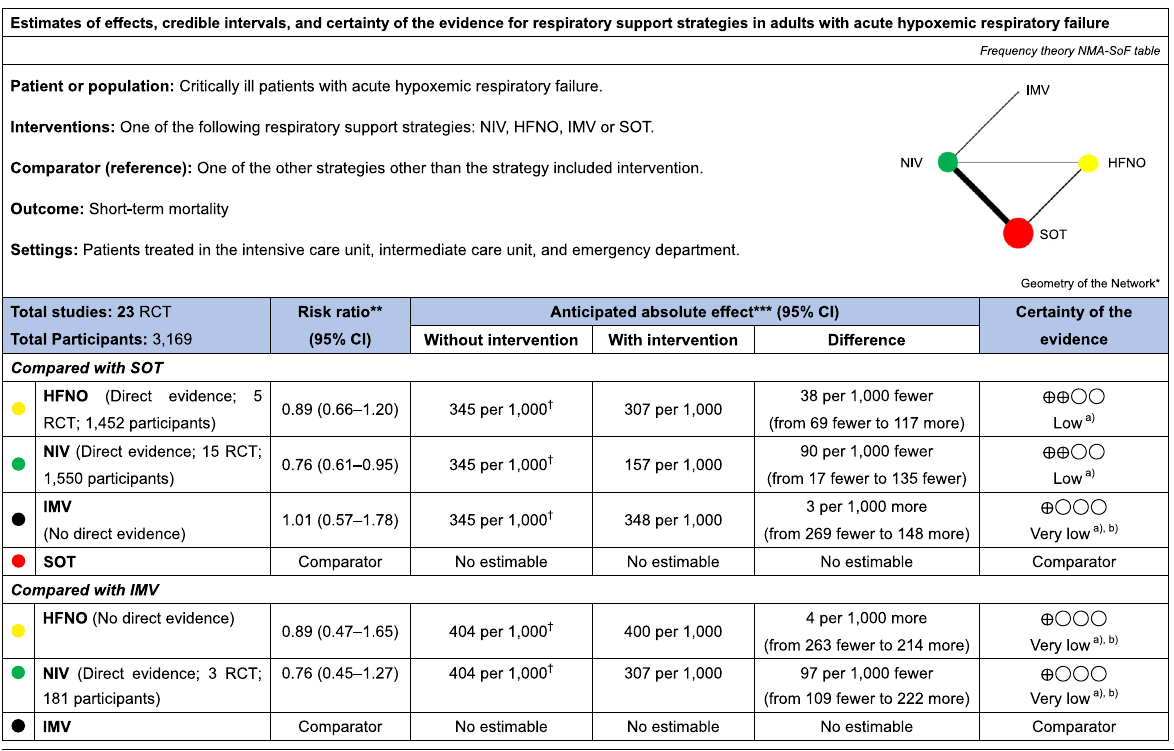
Table 3 Summary of findings of the network meta-analysis for short-term